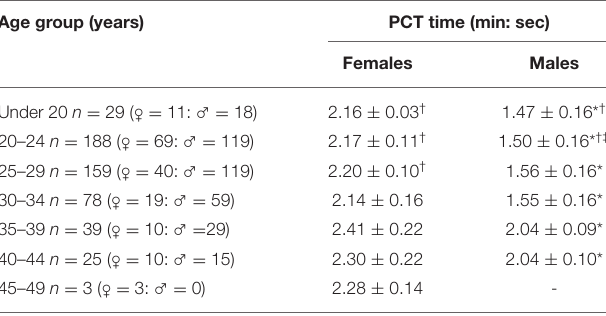
TABLE 1 | Profile of PCT results by sex in 5-year age